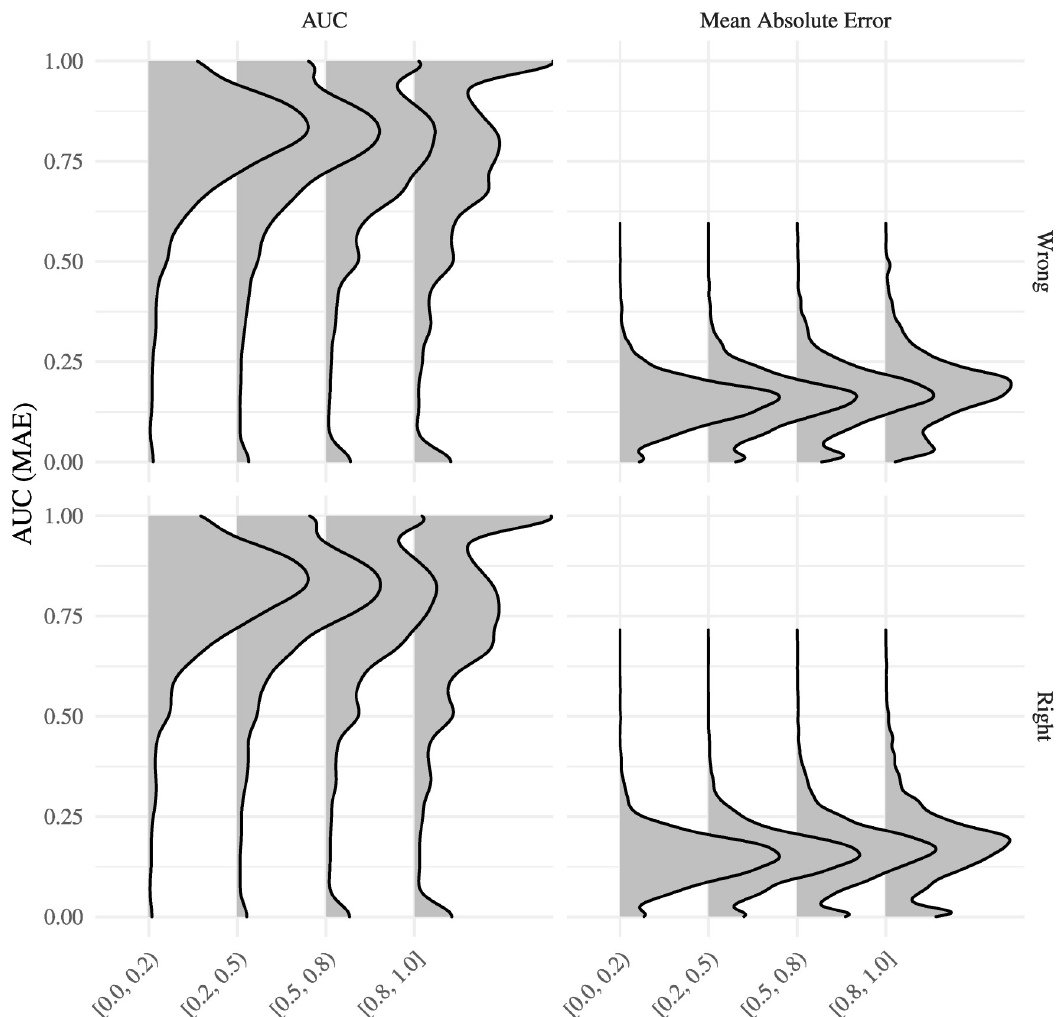
Fig 10. Distribution of AUCs and MAEs for the scenario with partially annotated trees and mislabeling. The x-axis shows the proportion of missing annotations, while the y-axis shows the score (AUC or